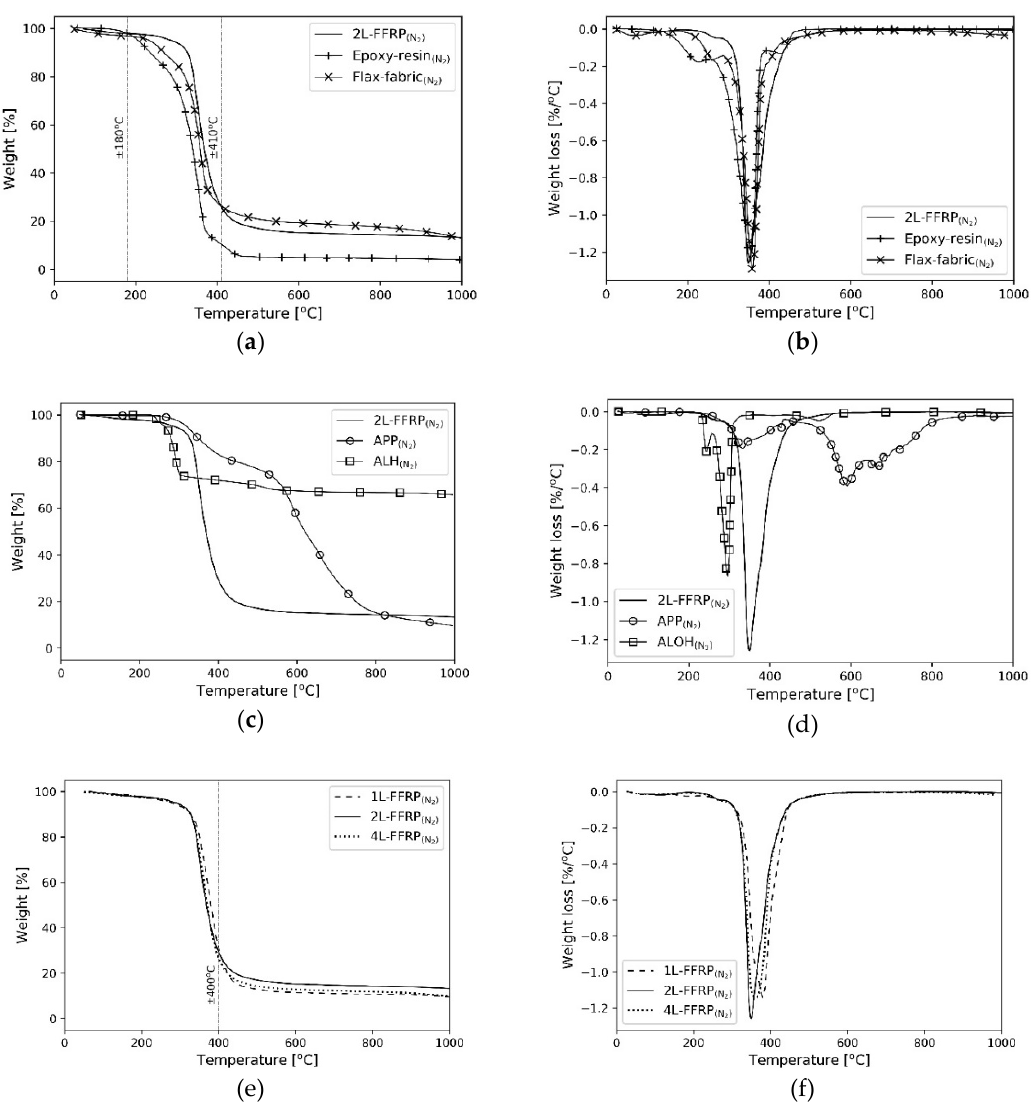
F igure 3. TGA and DTG curves in nitrogen atmosphere of FFRP composite with: ( a,b ) flax and epoxy Figure 3. TGA and DTG curves in nitrogen atmosphere of FFRP composite with: ( a , b ) flax and epoxy components; ( c,d ) fire-retardant compounds; and ( e,f ) different number of layers. components; ( c , d ) fire-retardant compounds; and ( e , f ) di ff erent number of